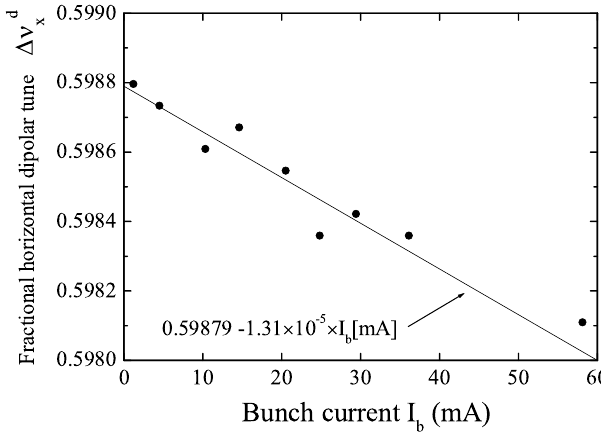
FIG. 6. Responses of the vertical quadrupolar oscillations under several bunch currents. Ten measured traces at every current were superposed. The traces for different currents were separated from each other by adding artificial offsets (60 dB between neighboring